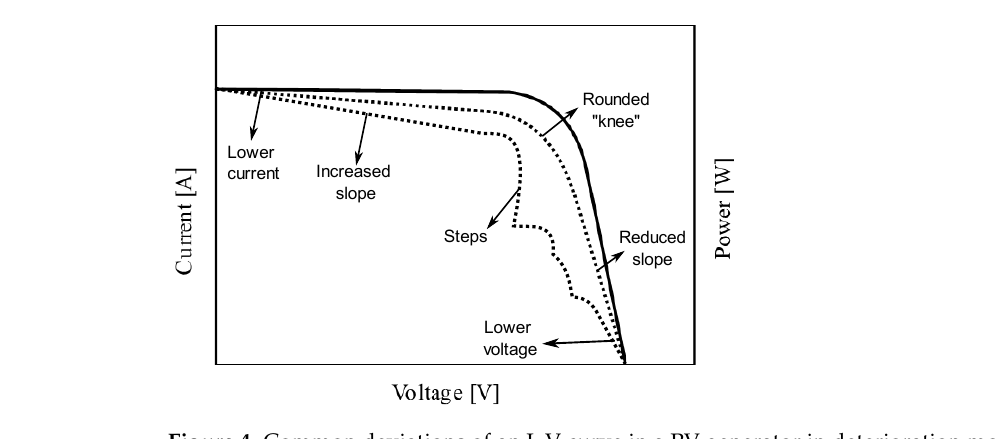
Figure 4. Common deviations of an I–V curve in a PV generator in deterioration mode. Source [12], own elaboration.